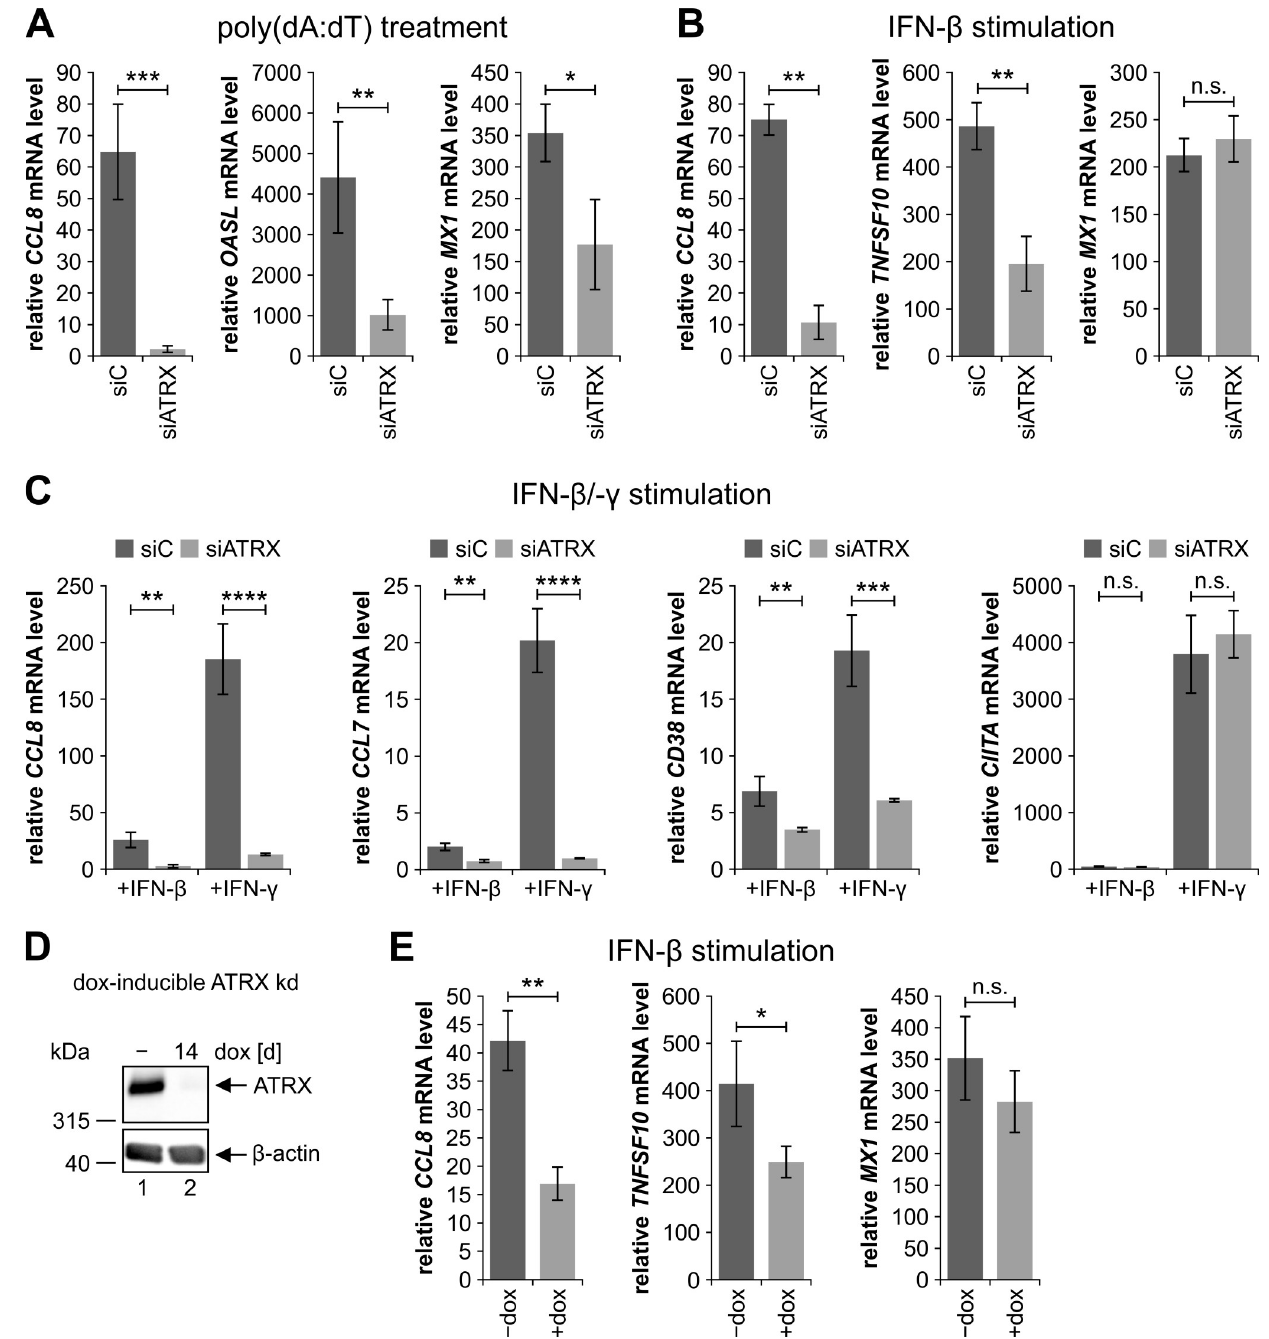
Fig 5. Impaired ISG expression in ATRX knockdown HFFs. (A-C) ATRX knockdown HFFs (siATRX) and respective control cells (siC) were treated with (A) 0.1 μ g/ml poly(dA:dT), (B) IFN- β (3.28 to 3.75 × 10 3 U/ml), or (C) IFN- β (3.87 × 10 3 U/ml) and IFN- γ (0.2 μ g/ml) for 24 h. Subsequently, total RNAs were prepared and RT-qPCR was performed to determine transcription of the ISGs (A) CCL8 , OASL and MX1 , (B) CCL8 , TNFSF10 and MX1 or (C) CCL8 , CCL7 , CD38 and CIITA . (D) HFFs with a doxycycline-inducible expression of an shRNA targeting ATRX were either left untreated ( − ) or treated with 500 ng/ml doxycycline (dox) for 14 days (d). Subsequently, cells were harvested for Western blot analyses to determine the knockdown efficiency; β -actin served as an internal loading control. The following antibodies were used: anti-ATRX (39-f), anti- β -actin (AC-15). kd: knockdown (E) Doxycycline-inducible ATRX knockdown HFFs were either left untreated ( − dox) or treated with 500 ng/ml dox for 14 d to induce an ATRX knockdown, followed by stimulation with IFN- β (3.75 × 10 3 U/ml) for 24 h. Subsequently, total RNAs were prepared and RT-qPCR was performed to determine transcription of the ISGs CCL8 , TNFSF10 and MX1 . (A+B+C+E) Depicted values were calculated from triplicates relative to untreated control cells using GAPDH as a housekeeping gene and are shown as mean ± SD. One out of at least two independent experiments is shown. Statistical analysis was performed with respective Δ Cq-values using a student’s t -test (unpaired, two-tailed); n.s.: not significant, � p < 0.05, �� p < 0.01, ��� p < 0.001, ���� p < 0.0001. https://doi.org/10.1371/journal.ppat.1010748.g005 PLOS Pathogens| https://doi.org/10.1371/journal.ppat.1010748 August 8,